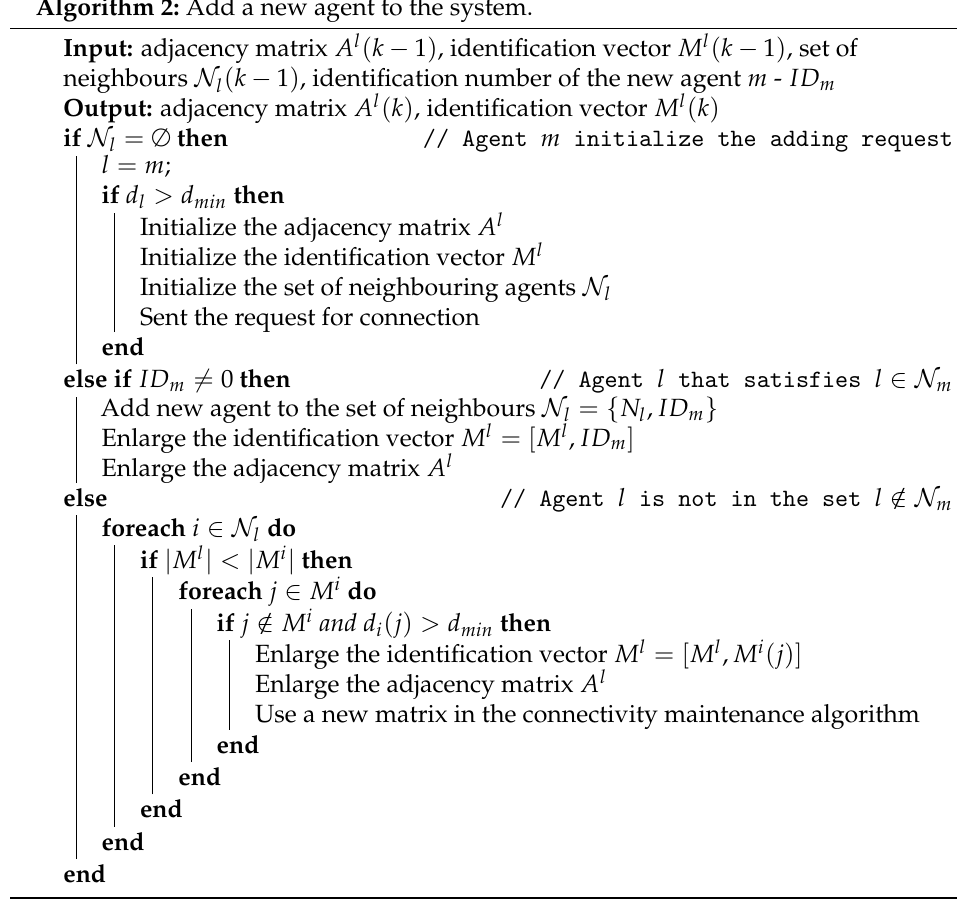
Algorithm 2: Add a new agent to the